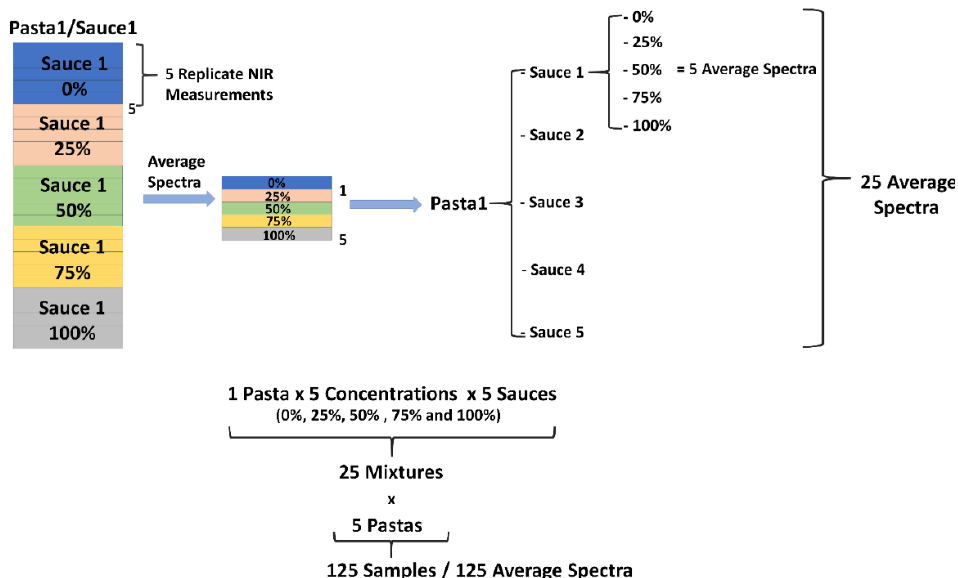
Figure 2. Sample preparation and spectra acquisition scheme demonstrated exemplarily for Pasta 1 and Sauce 1.